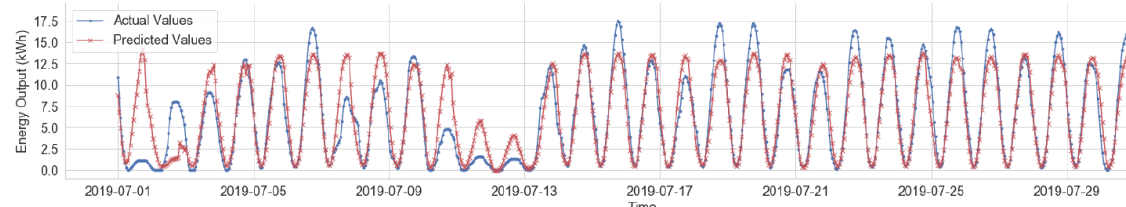
Figure 12: Snapshot of 12-hour predictions for 1 month: July, 2019